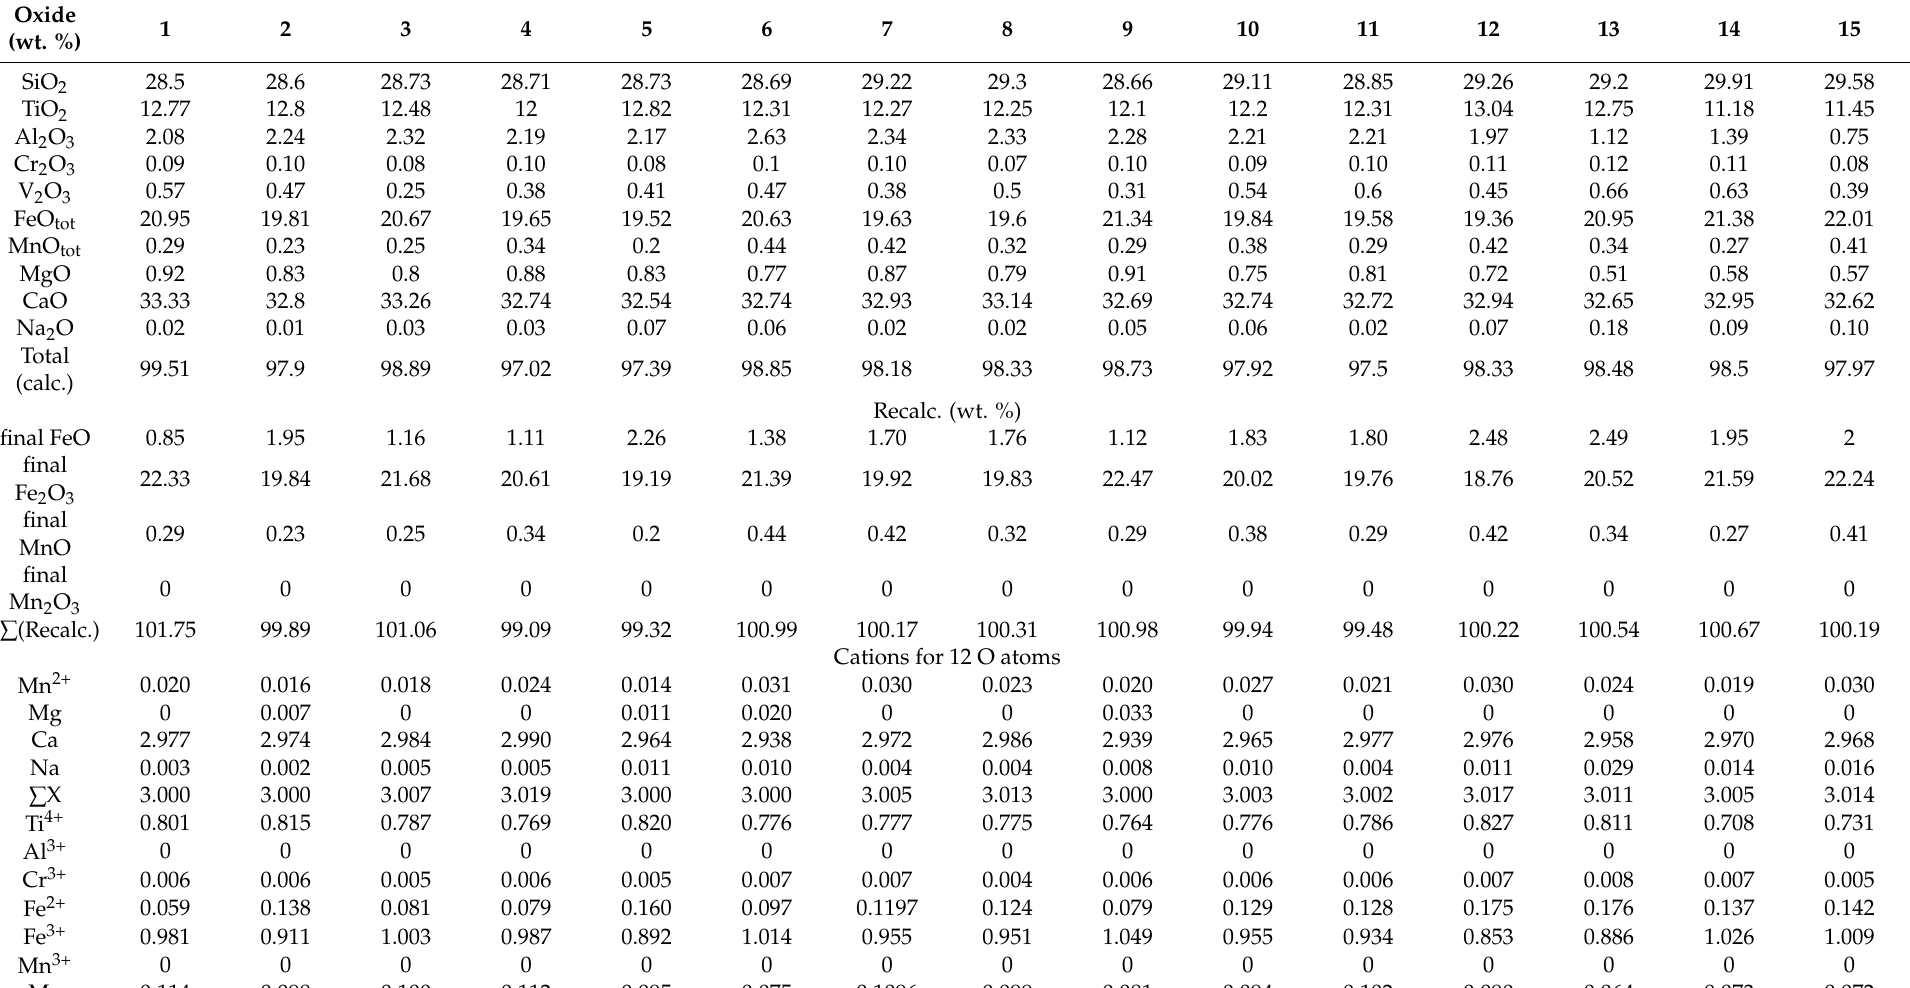
Table 1. Representative EMPA data (wt. %) of garnets from the carbonatite agglomeratic/brecciated intrusive, ASACC. As there are no vacancies in the X and Y site, therefore, the studied garnet is considered as anhydrous.